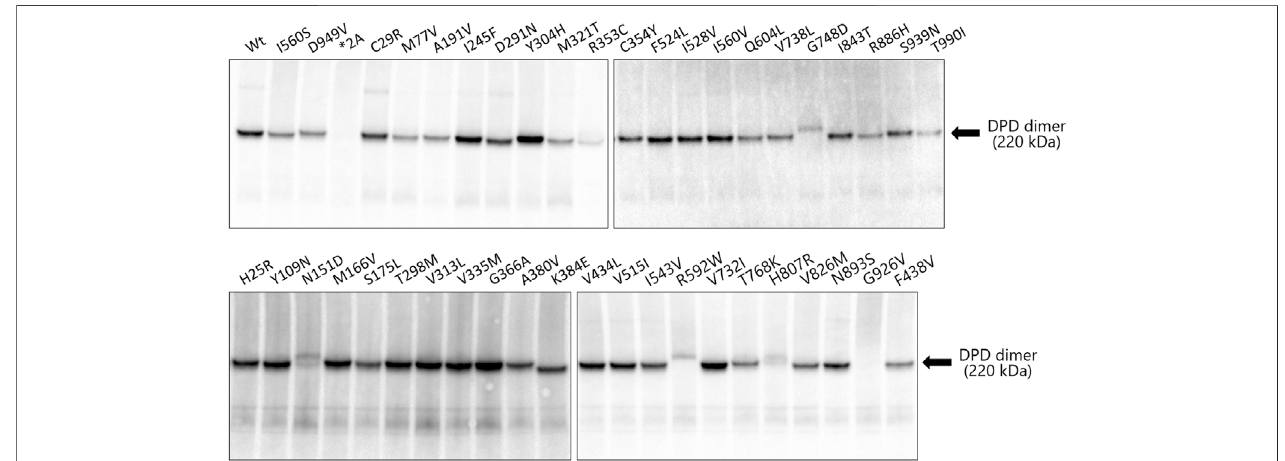
FIGURE 4 | Immunoblotting analysis after blue native PAGE showing immunoreactive dihydropyrimidine dehydrogenase (DPD) variant proteins. Blue native PAGE was performed using Tris-glycine buffer and 5% – 20% polyacrylamide gels; 9 μ g of the soluble fraction of DPD variant proteins were loaded into each lane in triplicate. DPD variants were detected using polyclonal antibodies against human DPD.